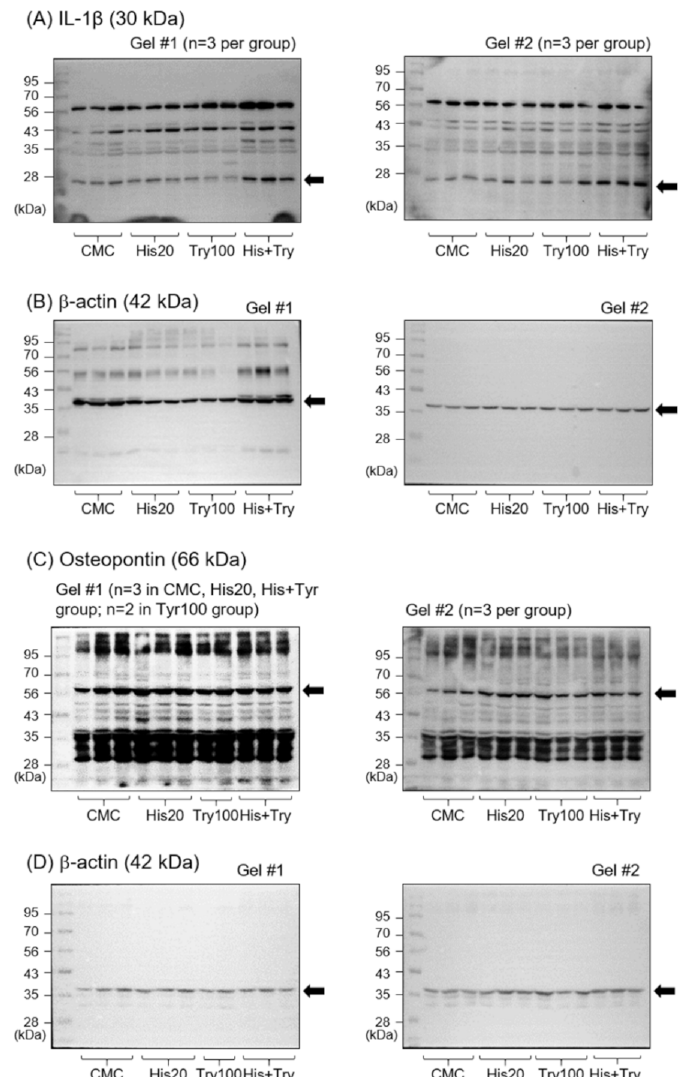
Figure A1. The full-length and whole Western blot images corresponding to Figure 2. ( A ) IL- 1 β . ( B ) β -actin for IL-1 β . ( C ) Osteopontin. ( D ) β -actin for osteopontin. The arrows indicate the appropriate molecular weight of each